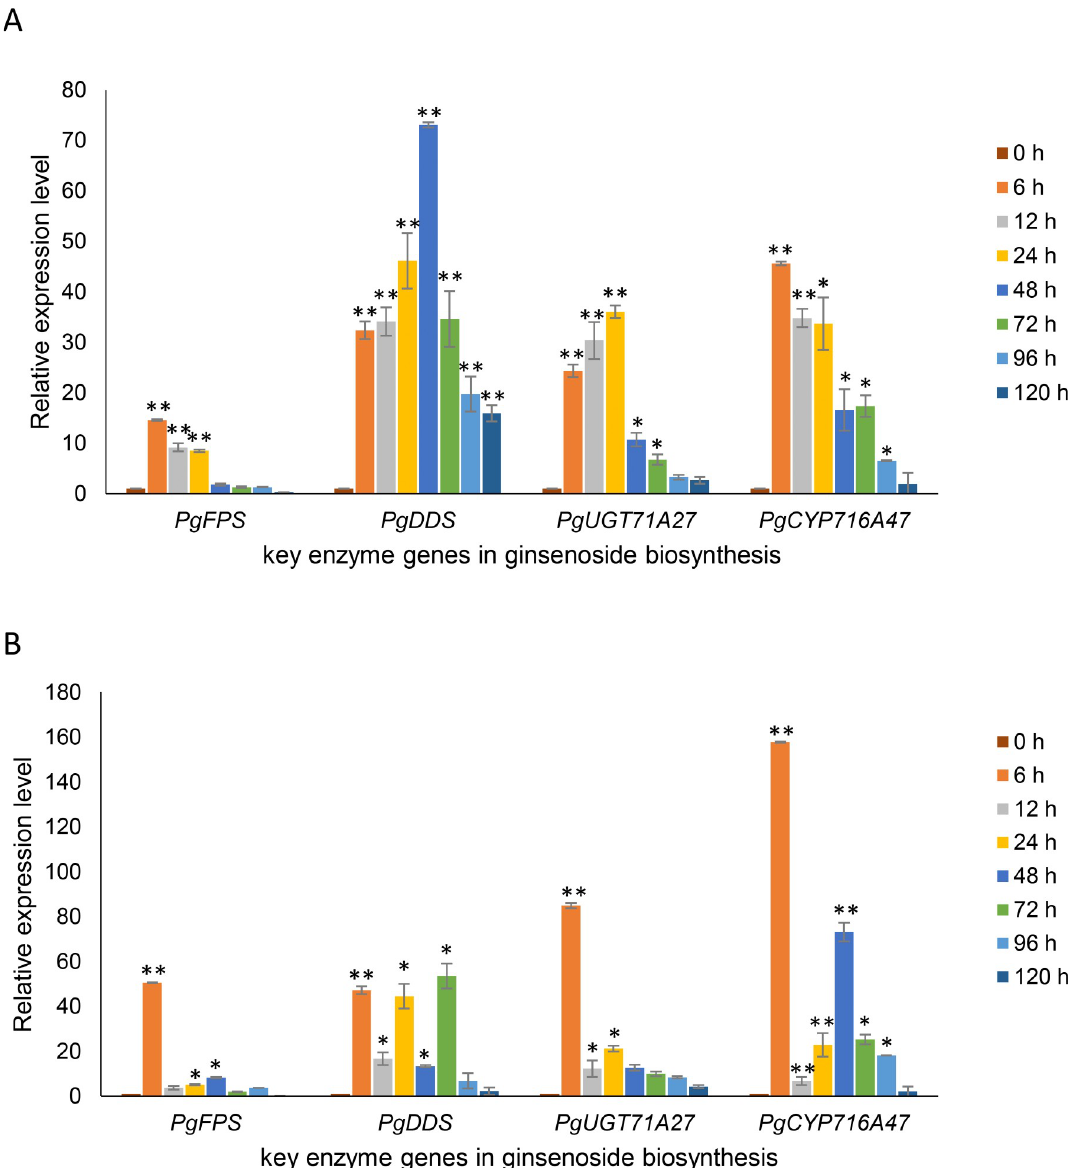
Fig 4. The relative expression levels of key enzyme genes involved in ginsenoside biosynthesis under MeJA treatment with CYP or 18S as the reference gene. (A) Relative expression levels of the four genes correlated with ginsenoside biosynthesis with CYP as the reference gene. (B) Relative expression levels of the four genes correlated with ginsenoside biosynthesis with 18S as the reference gene. The significance was calculated against the expression of no-treated hairy-roots by t -test. “ � ” for a two-tailed significance of P � 0.05, “ �� ” for a two-tailed significance of P �